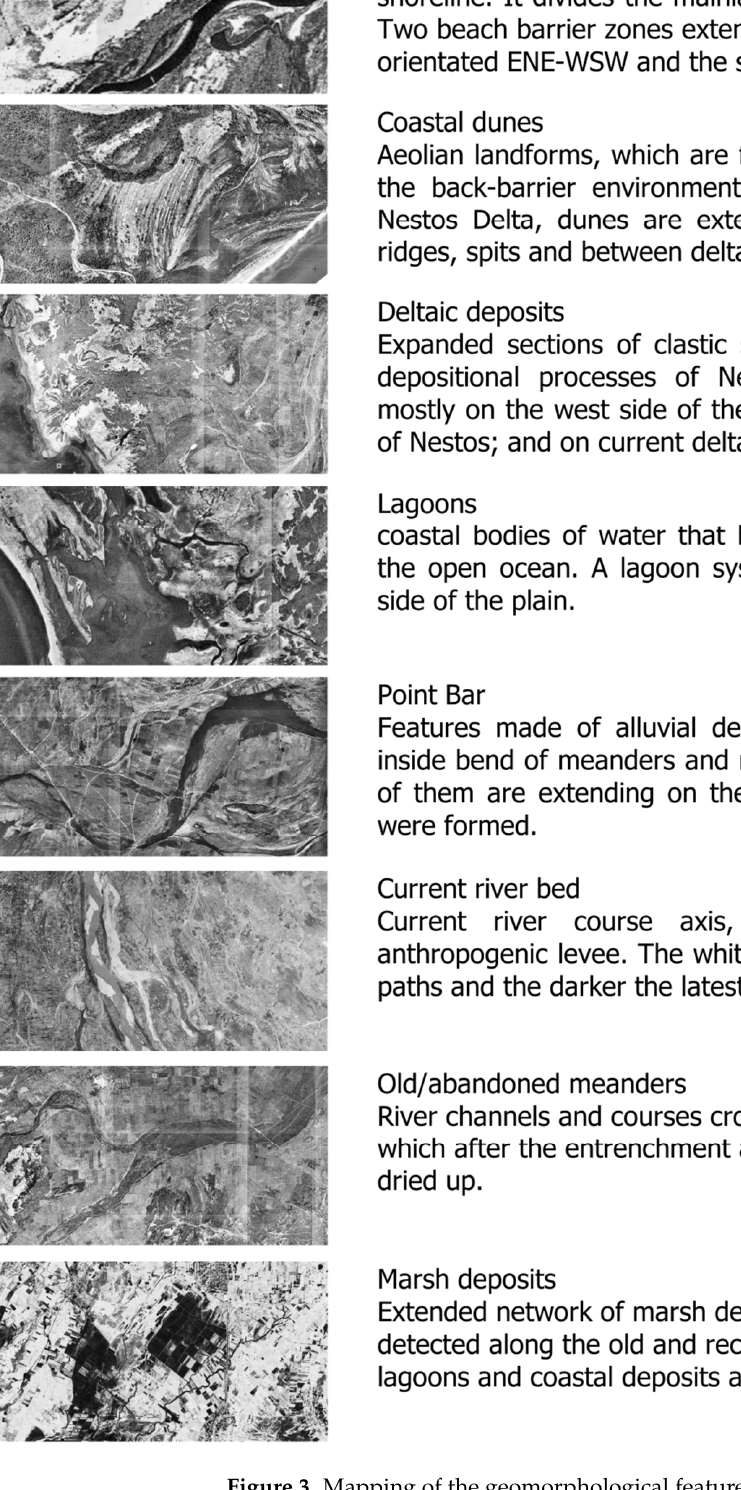
Figure 3. Mapping of the geomorphological features using orthophoto maps from 1945 and KH-4 Corona frames.